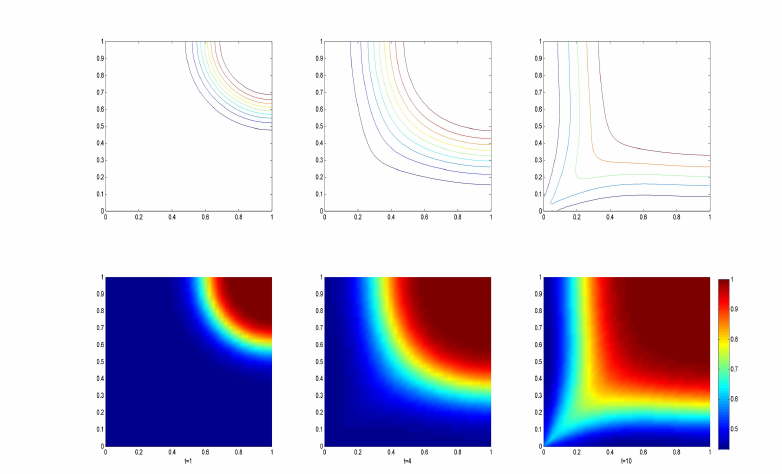
Figure 2. Contours and graphs of concentration in single injection single production case.